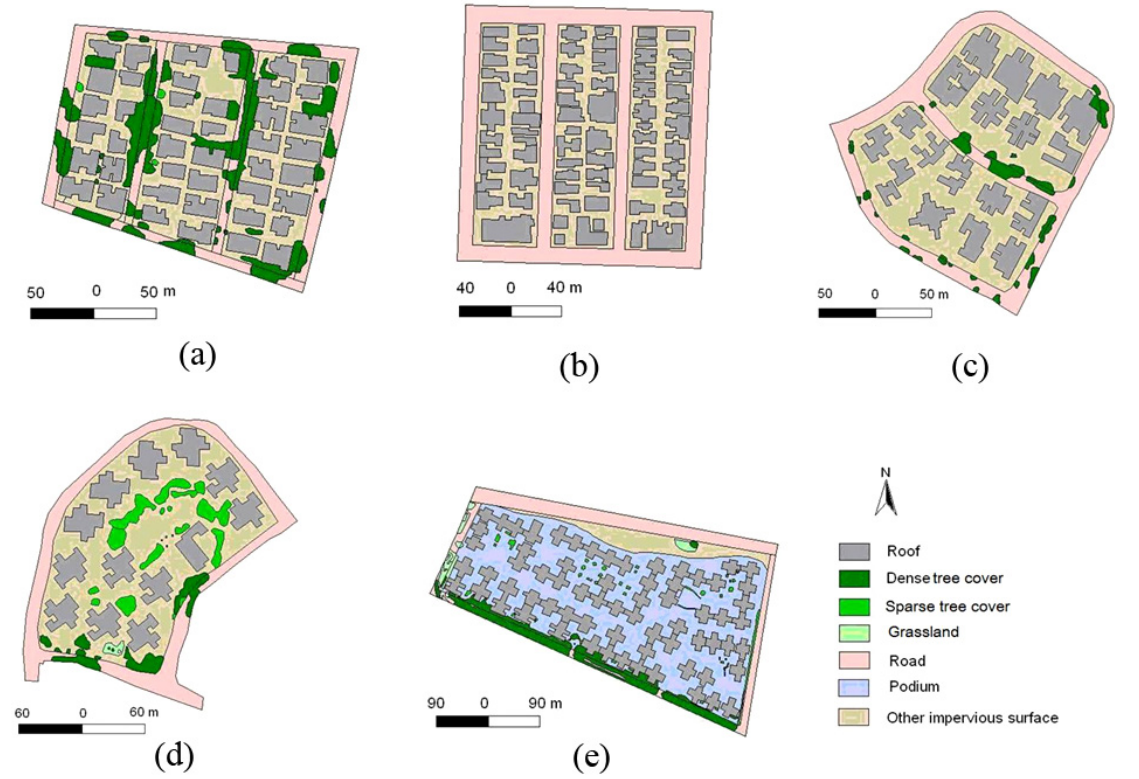
Figure 1. Town plan and land cover types of the five study sites (drawings a – e respectively for Kowloon Tong (KT), Kowloon City (KC), Broadcast (BC), Chun Man (CM) and Mei Foo